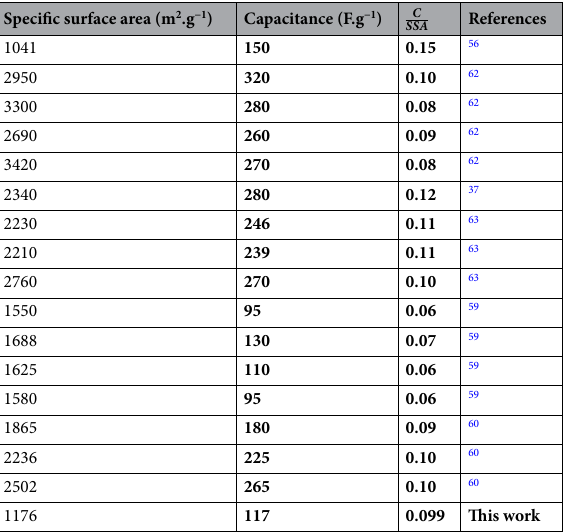
Specific surface area (m 2 .g −1 ) Capacitance (F.g −1 ) C